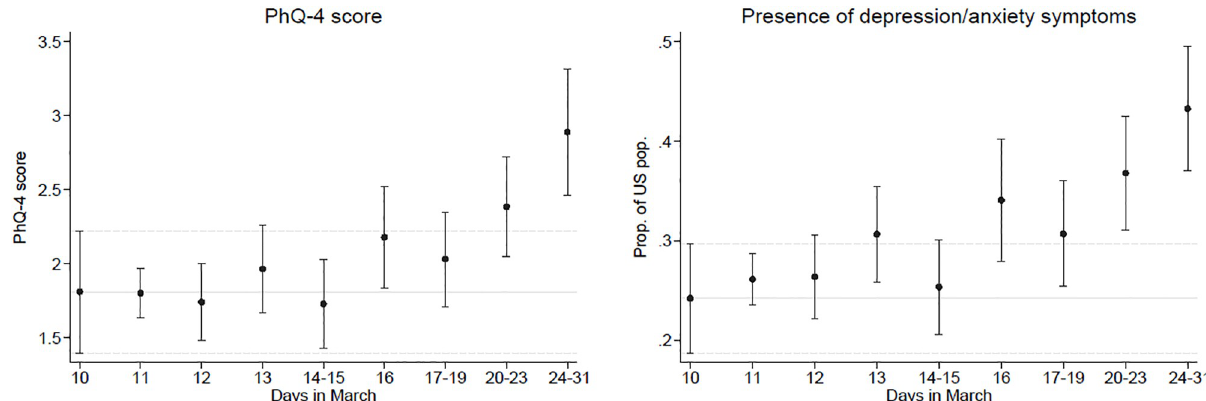
Fig 1. Changes in the mental health (PhQ-4) from March 10th to March 31st. Notes : Source of Data: “Understand America Study” (UAS), survey 230, collected between March 10 and March 31, 2020. Plots shows weighted means, along with 95% confidence intervals, of PhQ-4 score on the left and weighted proportions of the US population that has at least some depressive/anxiety symptoms on the right. We use post-stratification weights so that the weighted means and proportions are representative of the US population for each particular time period on the x